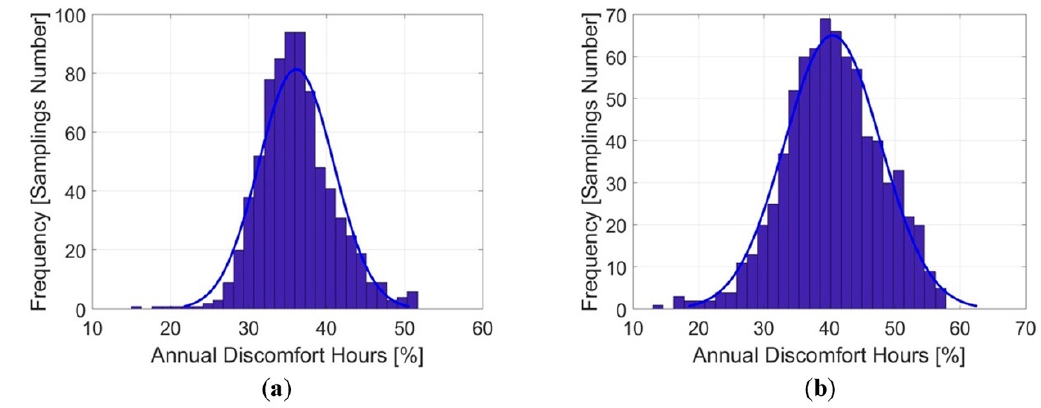
Figure 6. Distribution of DH c values in the building category. Summer period (June–August): ( a ) under typical climatic conditions; ( b ) for the 2050 climate scenario.